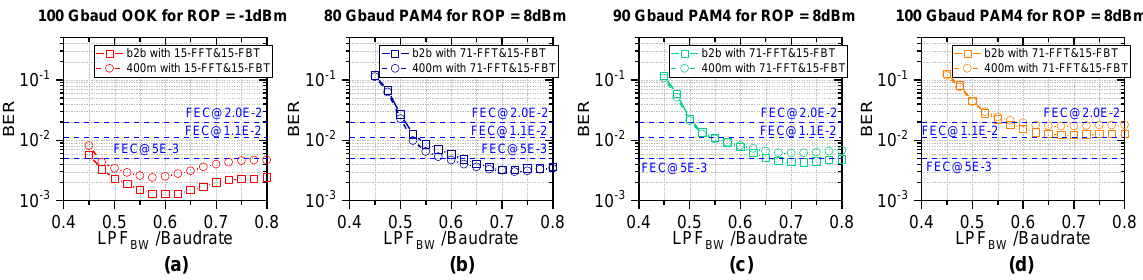
Figure 3. Bit error rate versus LPF bw /baud rate for ( a ) 100 Gbaud OOK, ( b ) 80 Gbaud PAM4, ( c ) 90 Gbaud PAM4, and ( d ) 100 Gbaud PAM4 signals. We use minus 1 dBm received optical power for OOK and 8 dBm for PAM4 signals.